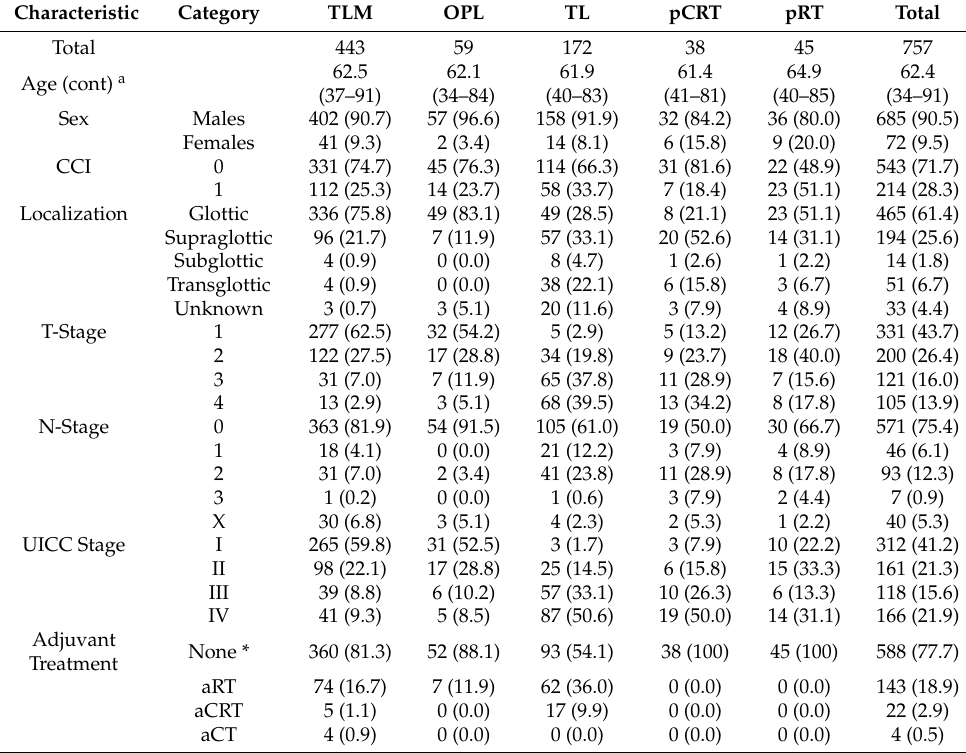
Table 1. Demographic and clinical characteristics of 757 laryngeal cancer patients.